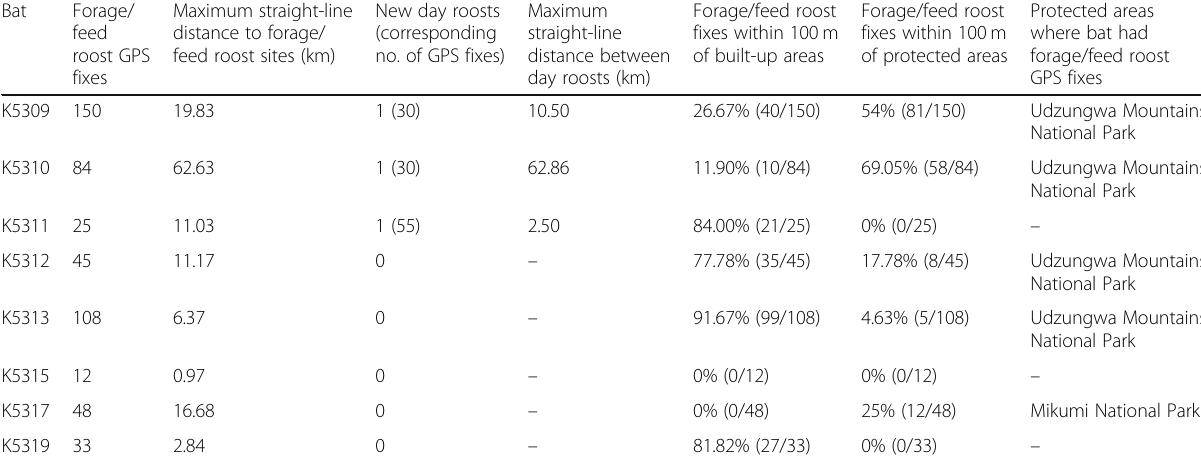
Table 2 Number and characteristics of foraging areas/feeding roost locations and new day roosts for e-obs tagged bats Bat Forage/ feed roost GPS fixes